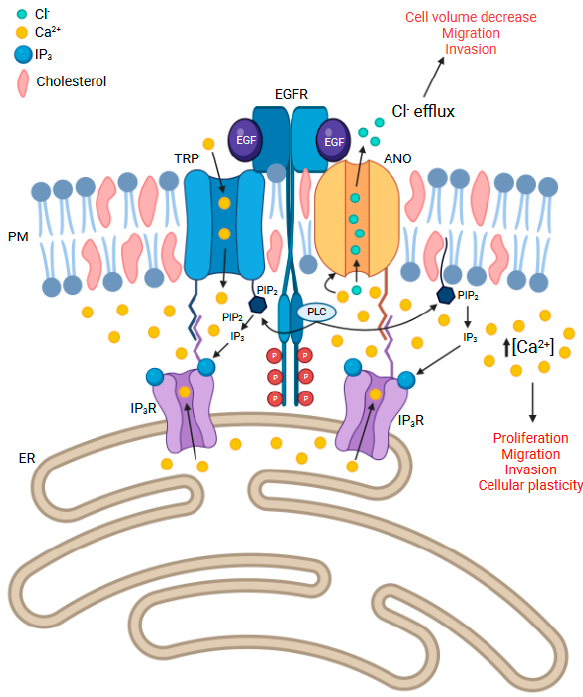
Figure 1. Anoctamin function in calcium-mediated cell signalling. In this model, ANO channels exist in lipid rafts within the plasma membrane, bound to receptor proteins such as EGFR, and other ion channels, such as TRP channels, for intracellular signalling. Through this interaction, calcium influx into the cell may activate ANO channels, stimulating chloride efflux and regulated volume decrease, leading to cell migration. Stimulation and activation of EGFR leads to PLC activation and cleavage of PIP 2 to form IP 3 . IP 3 activates the IP 3 R on the endoplasmic reticulum, causing the release of ER calcium stores. Through TRP channels and IP3R activation, localised calcium oscillations, and EGFR activation, may contribute to intracellular signalling and cellular plasticity. In an alternative